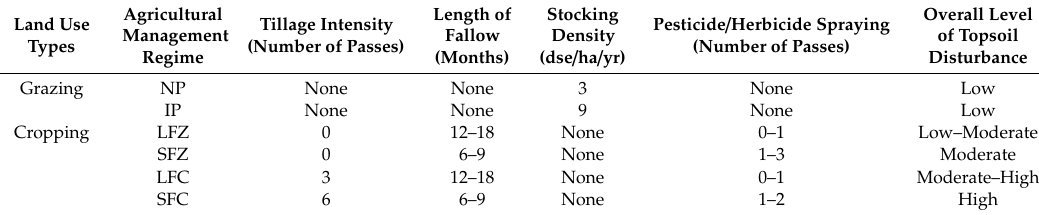
Table 1. Hypothesized overall topsoil disturbance typology in relation to agricultural management practices with native pasture (NP), introduced pasture (IP), long fallow zero tillage (LFZ), short fallow zero tillage (SFZ), long fallow conventional tillage (LFC), short fallow conventional tillage (SFC) based on typical regional